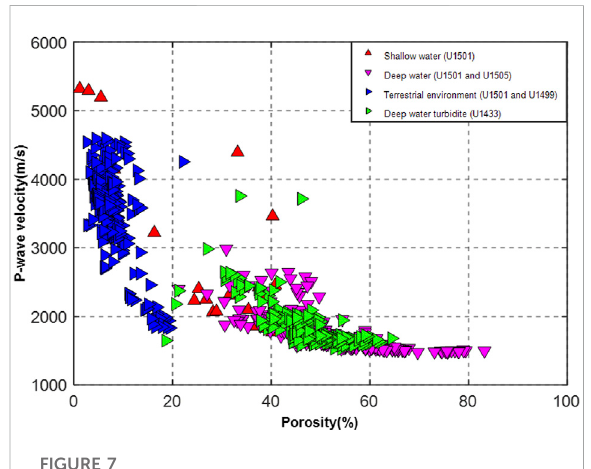
FIGURE 7 Cross plot of P-wave velocity versus porosity for IODP core data of sites U1501, U1505C, U1499, and U1433. Data points are color-coded by different depositional environments. FIGURE 8